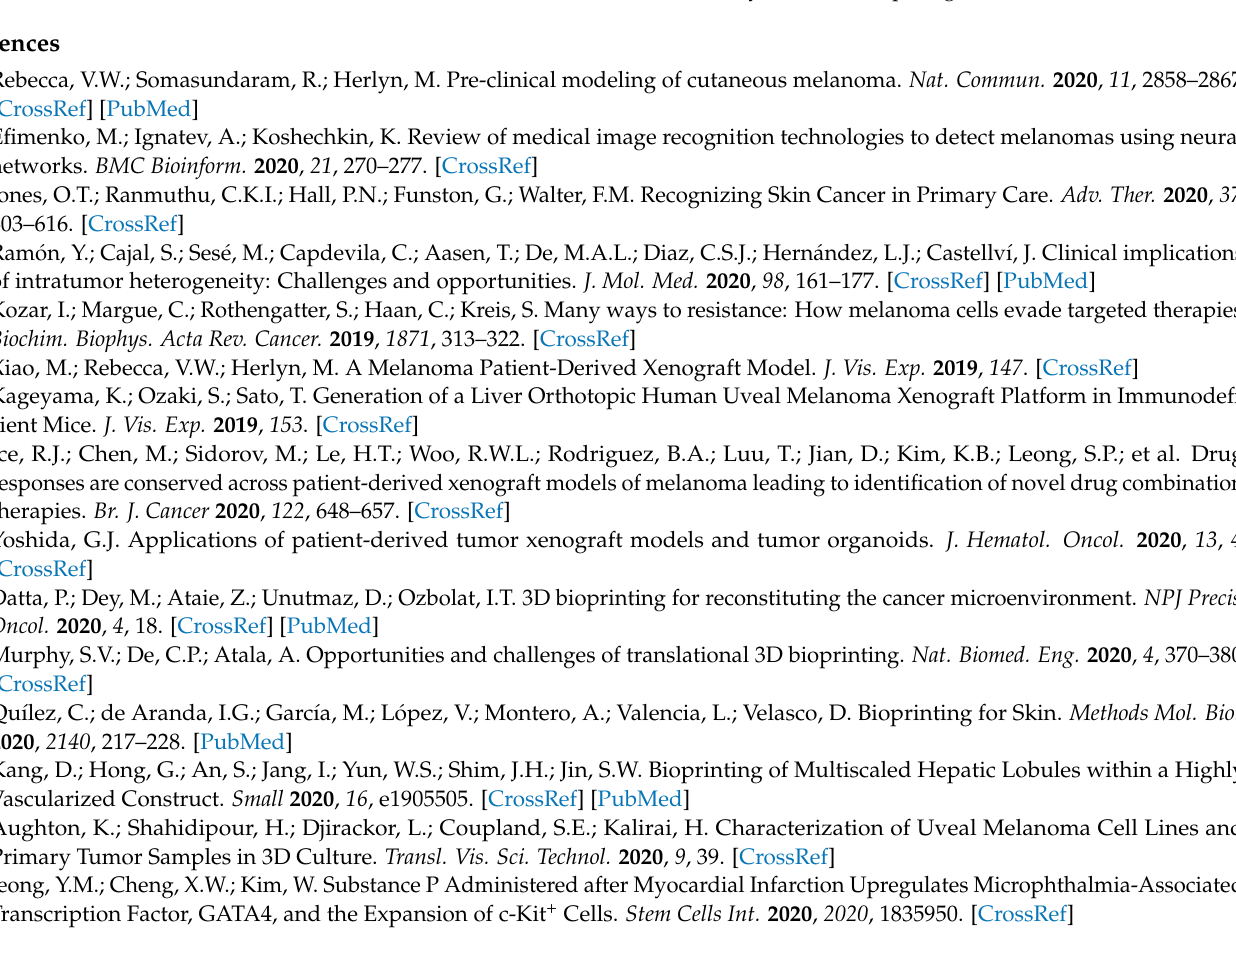
MPDX model. Figure S3: Expression of S100 in cryopreserved PDME cultured onto the 3D-printed collagen